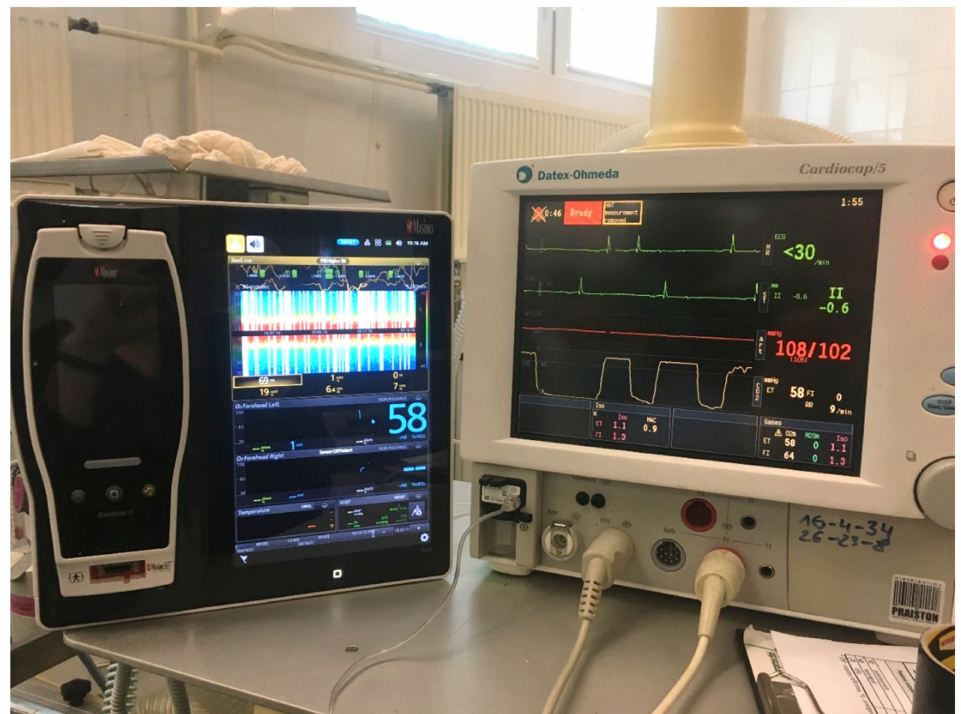
Figure 3. Multifunctional patient monitor (Datex Ohmeda Cardiocap S5, Helsinki, Finland), used routinely during anaesthesia (monitor on the right) and the monitor for brain oximetry (Root with Sedline, Masimo), measured with NIRS (on the left). This device also measures density spectral